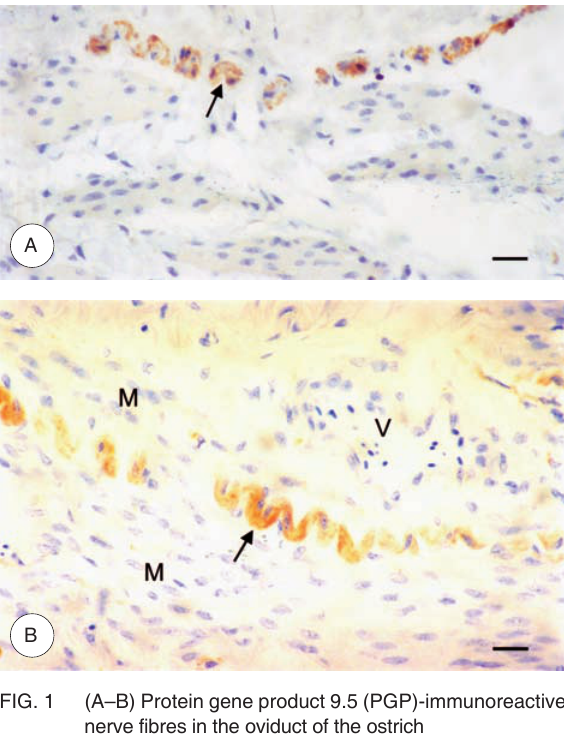
FIG. 1 (A–B) Protein gene product 9.5 (PGP)-immunoreactive nerve fibres in the oviduct of the ostrich (A) PGP-immu no reactive nerve fibre (arrow) in the lam- ina propria-sub mucosa of the magnum. (B) PGP-immu- noreactive nerve fibres (arrow) in the tunica muscularis of the isthmus are positioned parallel to the longitudinal axes of the smooth muscle cells (M). Note the blood vessel (V) associated with the nerve Scale bar = 50 μ m